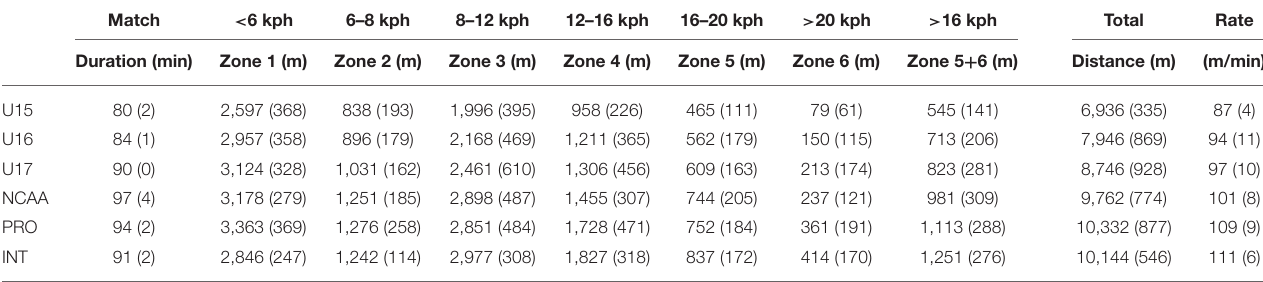
TABLE 2 | Locomotor distances and movement rate across standards.